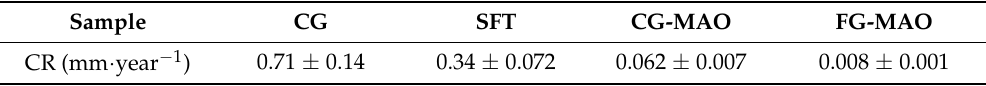
Table 3. The corrosion rate of samples calculated in accordance with Faraday’s law.